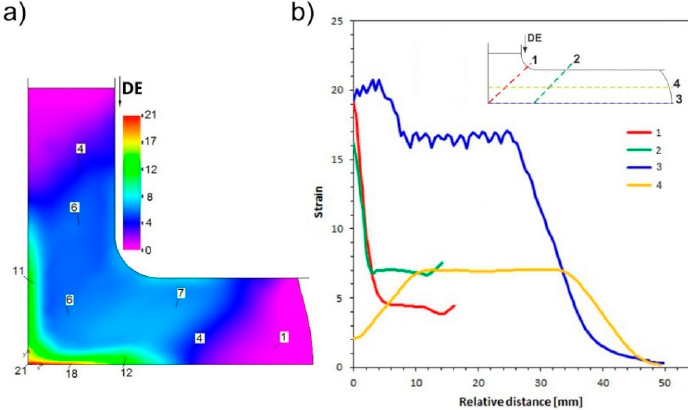
Figure 5. Equivalent plastic strain distribution ( ε ) at BP = 500 MPa: ( a ) First pass and ( b ) Sixth